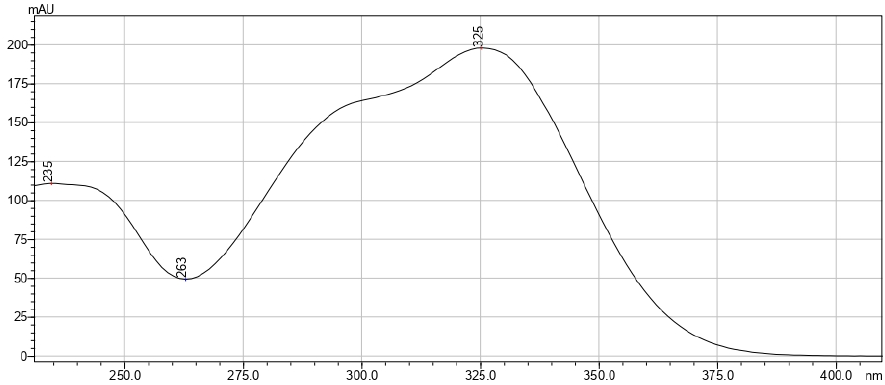
Figure 3. Absorption spectrum of chlorogenic acid isolated from T. vulgare extracts.